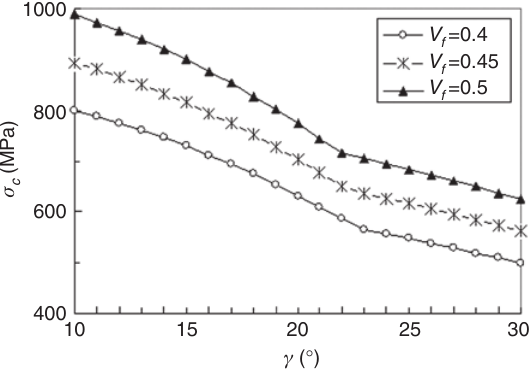
Figure 2: Variation of the longitudinal tensile strength with inner braiding angle.